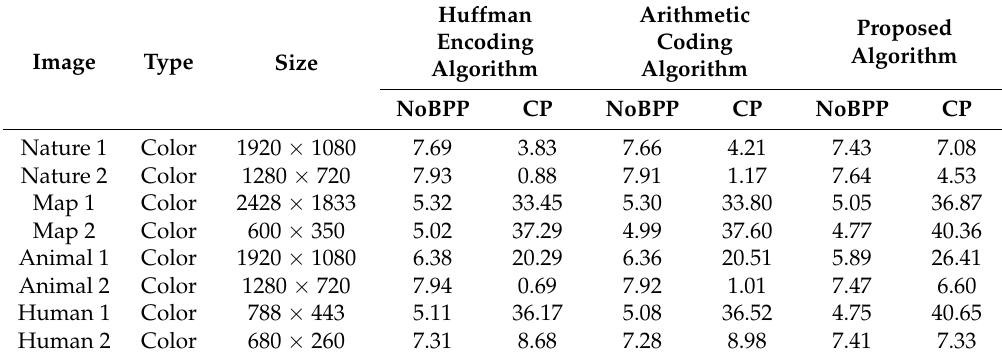
Table 8. Compression percentages of Group 2 images.